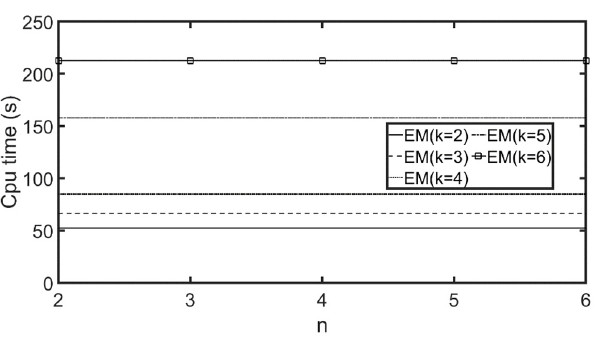
Figure 14. Computation time for customer similarity scores with different k , n ( α k = 4, α n = 4).